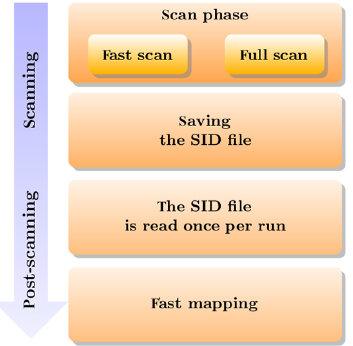
Figure 1. Schematic representation of the OBLIMAP 2.0 stand- alone version. The scanning consists of the scan phase and results in a SID file. The post-scanning consists of reading the SID file and loading its content in the DDO, whereafter the fast mapping of mul- tiple fields, layers and records can be repeated as often as